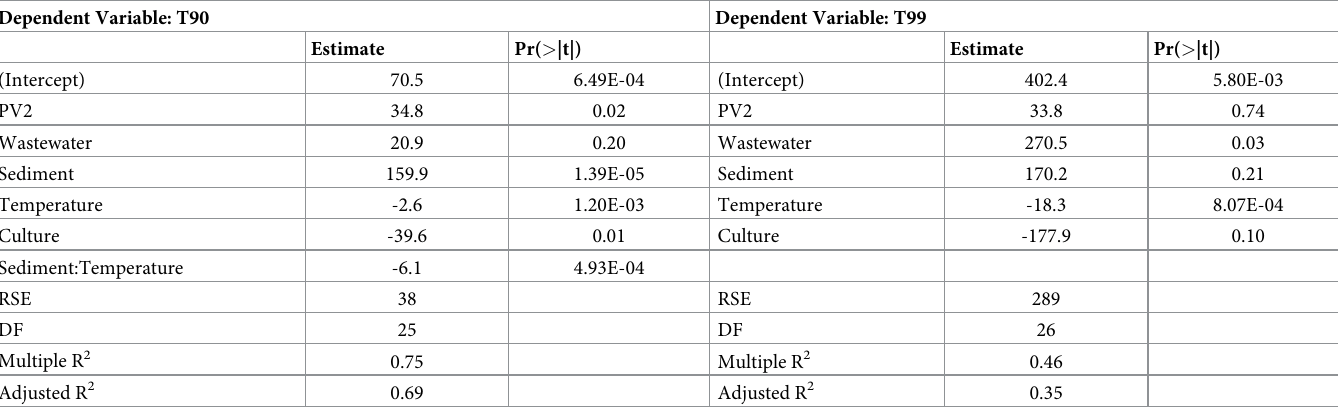
Table 2. Model coefficients for linear models of factor